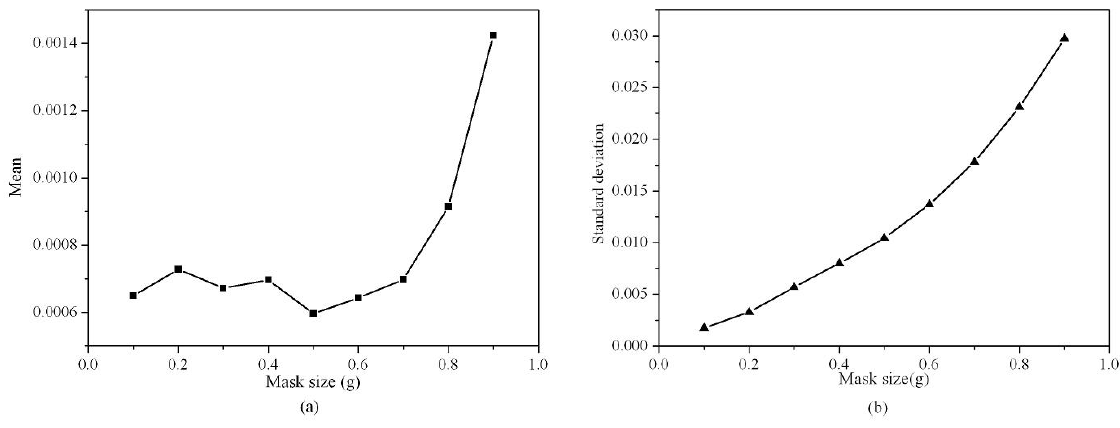
Figure 3. Mean and standard deviation of strain component ε GPA vs. mask size: ( a ) Mean vs . mask size; ( b ) Standard deviation vs. mask